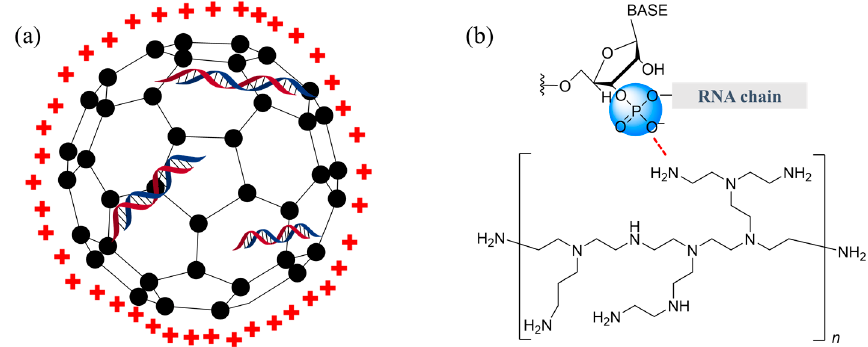
Figure 3. ( a ) Representation of RNAs contained inside carbon dots and ( b ) PEI-RNA interaction. Red-plus sign ( + ) represents positive charges on the surface of carbon dots. Black dots ( • ) represents carbon atom. Color image available online.